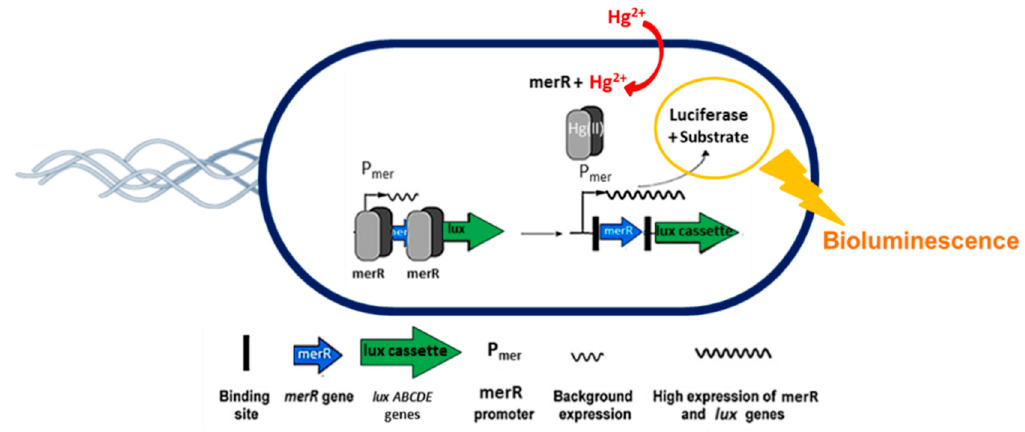
Figure 1. Mechanism of E. coli reporter induction by Hg 2+ (freely inspired figure